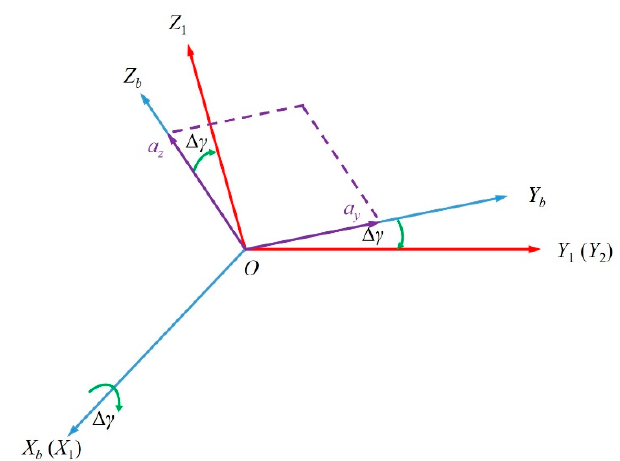
13 of 27 Figure 8. Installation deviation of SINS.